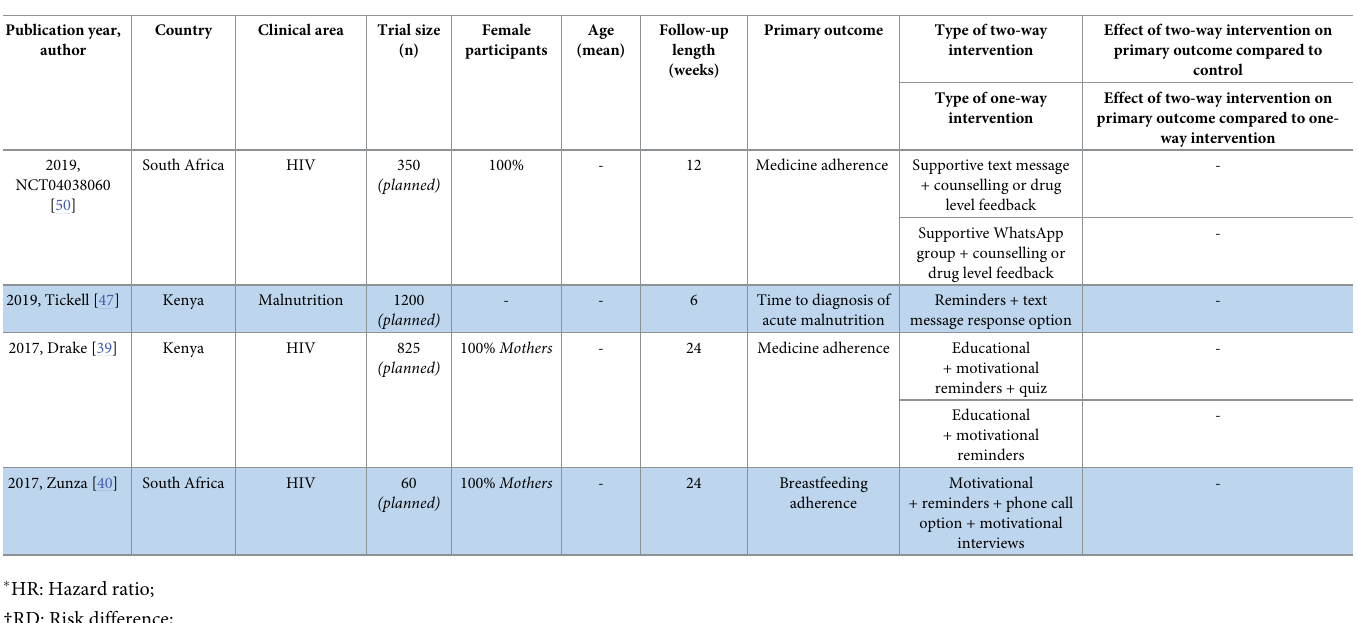
there was no statistically significant difference between intervention groups in facility delivery and contraceptive use. However, both one-way and two-way text messages improved